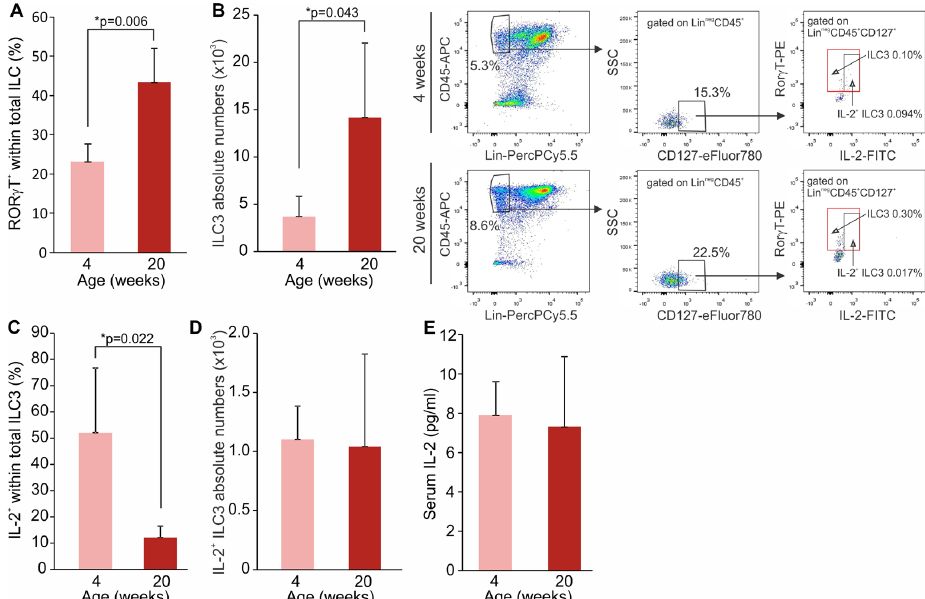
Figure 1. Mature NOD mice have lower frequencies of IL − 2-producing ILC3 in the SILP. Proportion of total ILC3 ( A ) and their absolute numbers ( B ). The percentages of IL − 2-producing cells among Lin neg CD45 + CD127 + ROR γ t + ILC3 ( C ) and their absolute numbers ( D ) in the SILP of prediabetic (4-weeks-old) and diabetic (20-weeks-old) NOD mice. Representative dot plots are shown. Serum IL-2 concentration ( E ). Number of mice per group was 6. * p < 0.05 was considered as statistically significant when samples from mature and young mice were compared.